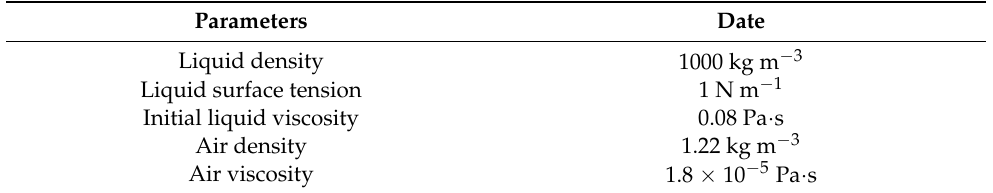
Table 1. Fluid properties’ parameters.